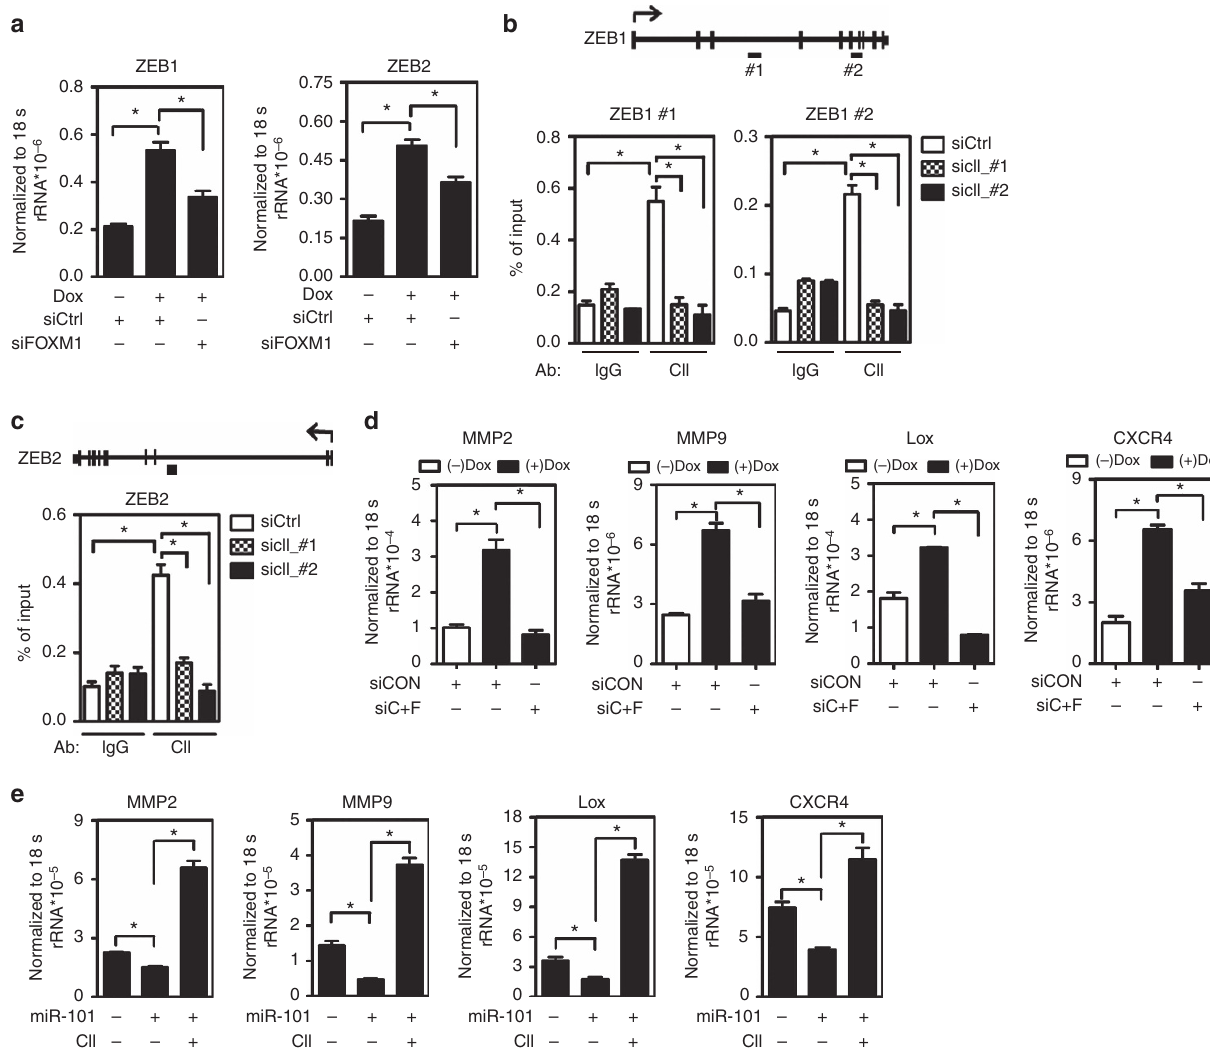
Figure 6 | COUP-TFII is a master regulator central to the metastatic gene regulatory network. ( a ) Levels of ZEB1 and ZEB2 expression in PC3 cells carrying an inducible COUP-TFII gene expression construct were determined after 72h treatment in the absence or the presence of doxycycline and FOXM1 siRNA ( n ¼ 3). * P o 0.05 (two-sided Student’s t -test). ( b , c ) A cartoon shows the ZEB1 and ZEB2 loci. COUP-TFII-binding sites as annotated by a black rectangle (upper panel). ChIP quantification results are shown in the PC3 cells treated with control or two different siRNAs against COUP-TFII for 72h (lower panel) ( n ¼ 3). * P o 0.05 (two-sided Student’s t -test) compared with control group. ( d ) Levels of MMP2, MMP9, LOX and CXCR4 in PC3 cells carrying an inducible COUP-TFII gene in the absence or the presence of doxycycline, and subsequent knock down of both CENPF and FOXM1 expression (siC þ F) for 72h ( n ¼ 3). * P o 0.05 (two-sided Student’s t -test). ( e ) Levels of MMP2, MMP9, LOX and CXCR4 in PC3 cells carrying an inducible miR-101 gene in the absence or the presence of doxycycline, and subsequent enforced expression of COUP-TFII for 96h ( n ¼ 3). * P o 0.05 (two-sided Student’s t